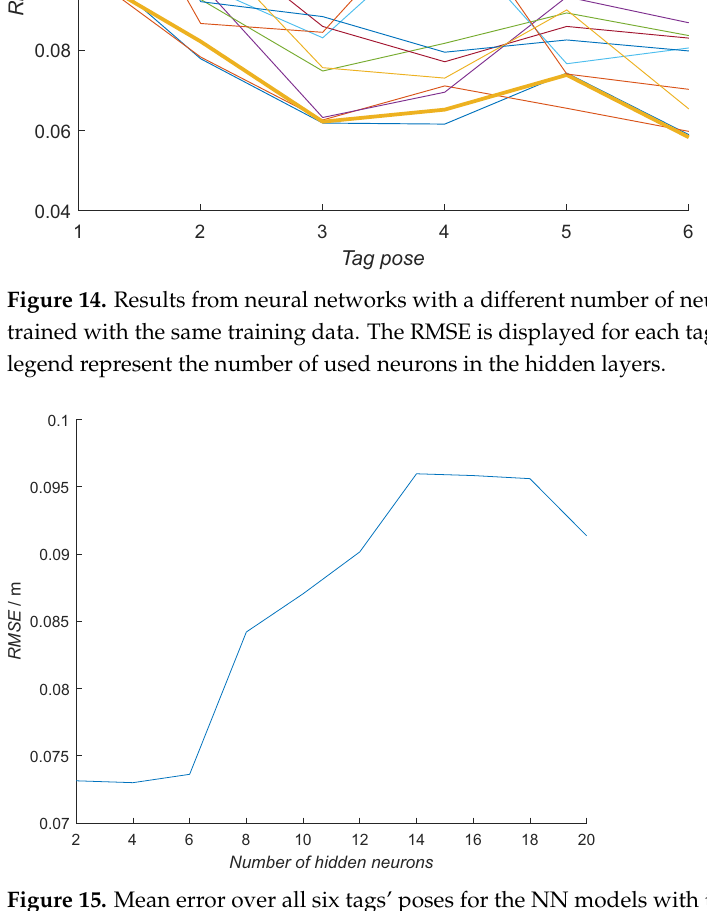
Figure 15. Mean error over all six tags’ poses for the NN models with the number of neurons from 2 to 20, with increments of 2 using the data from the RTLS experiment. The same process was repeated with a subset of data from the training experiment that was not used in the learning process (Figure 16 and Table 3 bottom row). The error with the subset of training data is decreasing with the increasing number of hidden neurons. The smallest errors are for NN models with 14, 16, 18 and 20 hidden neurons. Please note that the smallest RMSE values here are in the range of 0.033 m, while the smallest values in the RTLS experiment are 0.073